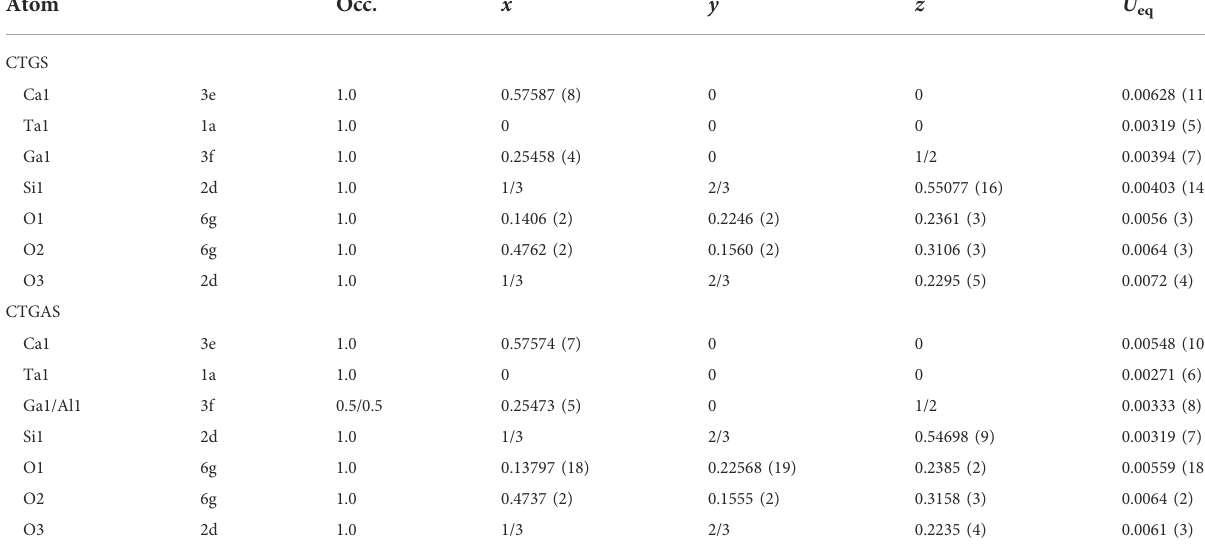
TABLE 2 Atomic positions, site occupancies, and equivalent isotropic displacement parameters ( U eq /Å 2 ) for CTGS and CTGAS crystals. Atom Occ.